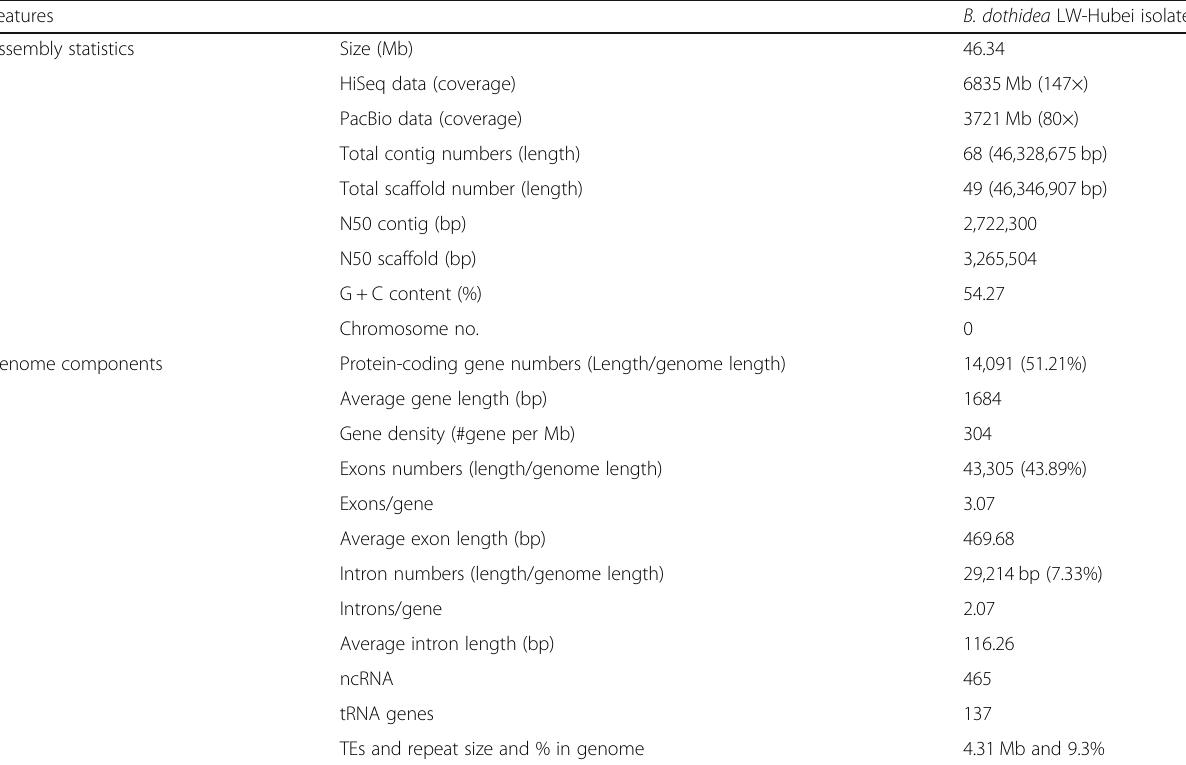
Table 1 Features of the Botryosphaeria dothidea LW-Hubei isolate genome Features